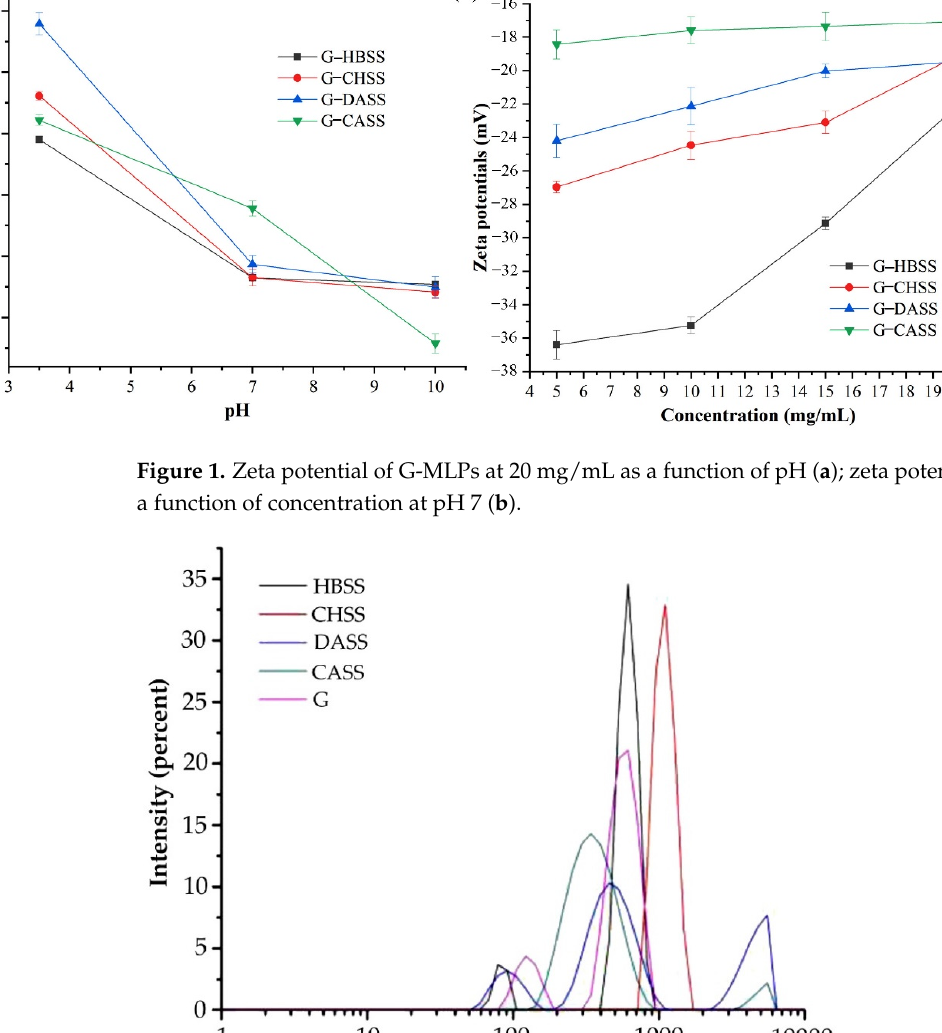
Figure 1. Zeta potential of G ‐ MLPs at 20 mg/mL as a function of pH ( a ); zeta potential of G ‐ MLPs as a function of concentration at pH 7 ( b ).